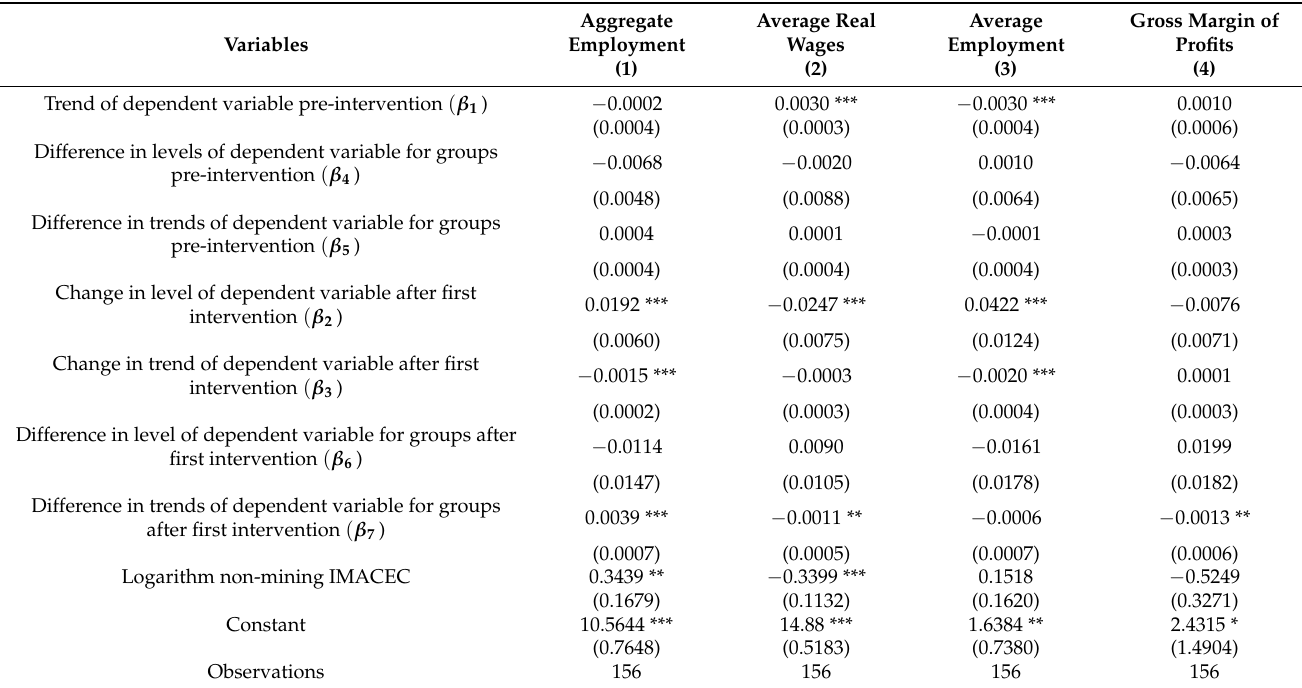
Table 3. Changes in labor market and firms’ profit outcomes considering one FOP regulation intervention (July